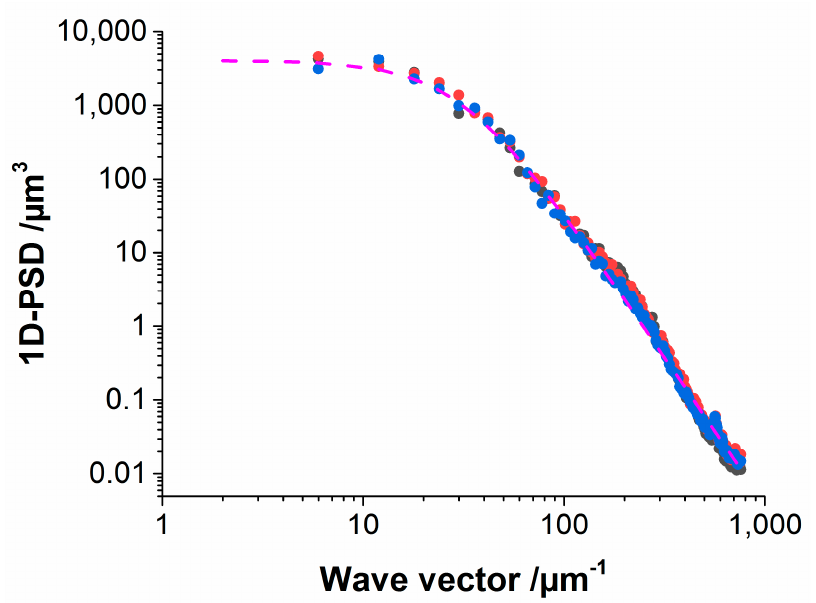
Figure 2. One-dimensional power spectral density of an SFMO thin film deposited by multi-target reactive sputtering at 600 °C (dots) in comparison with the ABC model, Equation (8) (dashed line). AFM scans were carried out at three different points with a scan area of 1.05 × 1.05 µm 2 .